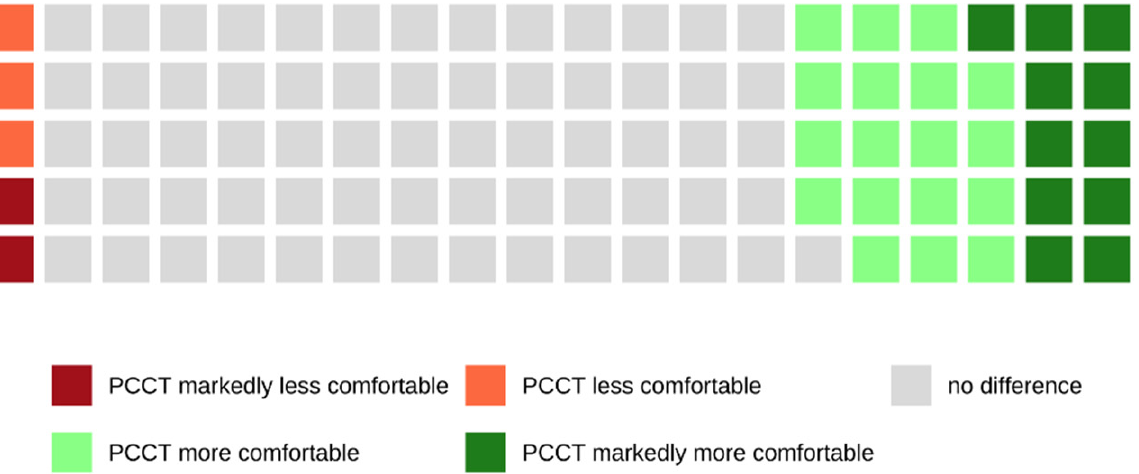
Figure 10. Waffle chart showing the comparison of both CT scanners in terms of